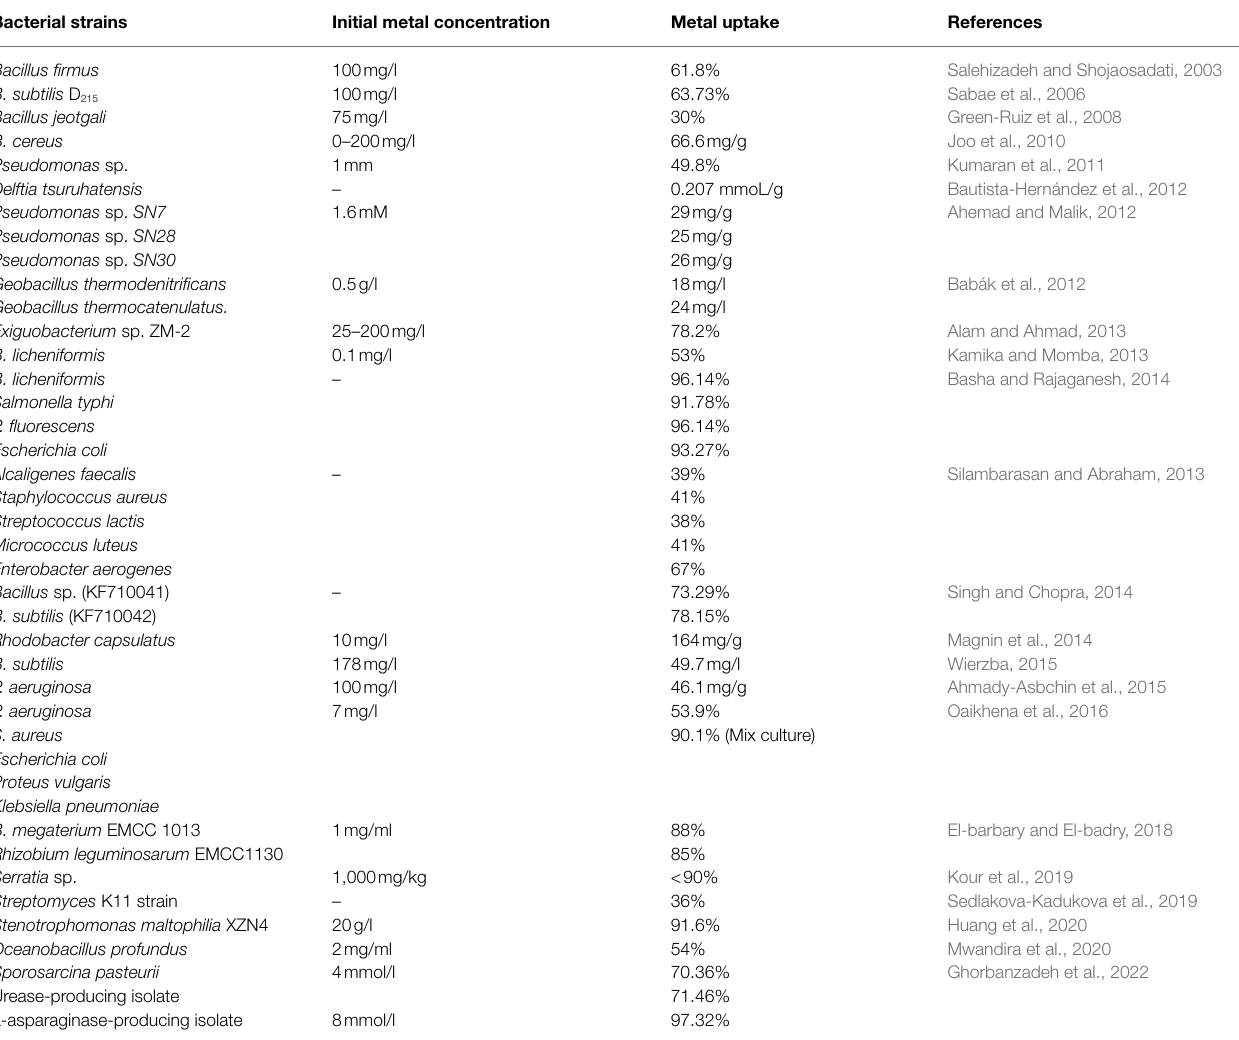
TABLE 3 | Zn biosorption and metal uptake ability of various Gram-positive and Gram-negative bacterial species, as reported in different studies. Bacterial strains Initial metal concentration Metal uptake